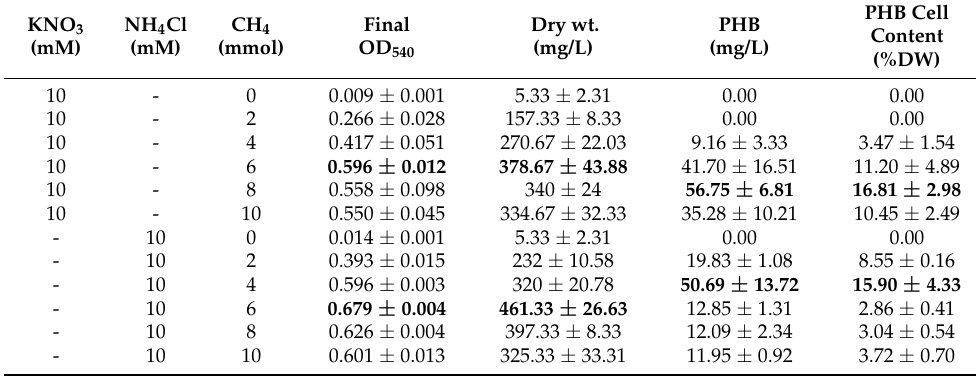
Table 1. Effect of methane amount (mmol) on growth (optical density, OD, at 540 nm), biomass (dry weight, DW, in mg/L), and PHB production (mg/L culture and PHB% of cell dry weight, DW) in batch cultures of Methylocystis sp. Rockwell grown with either nitrate or ammonium (10 mM) as the N-source ( n = 3). Values in bold are the highest levels achieved for each set of measurements. KNO 3